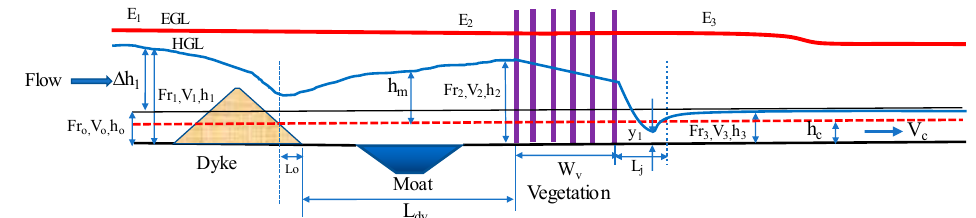
6 of 25 Figure 2. Experimental setup: ( a ) Schematic of the channel with models, ( b ) experimental setup of the hybrid defense system in the laboratory, ( c ) vegetation arrangement details of staggered strips (SS). Figure 3. Schematic diagram of experimental model. 2.1.3. Non-Dimensional Pi Groups